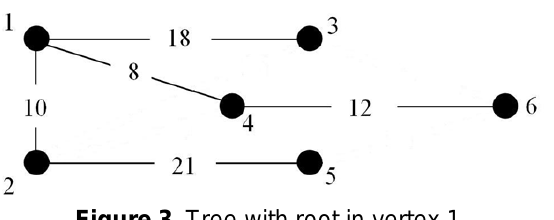
Figure 3. Tree with root in vertex